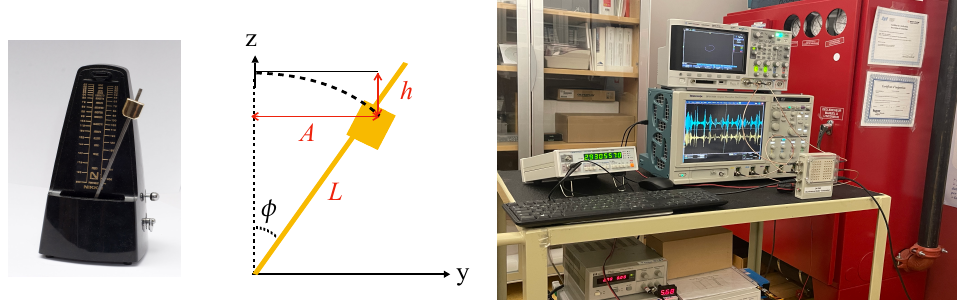
Figure 1. Metronome’s pendulum geometry, and experimental